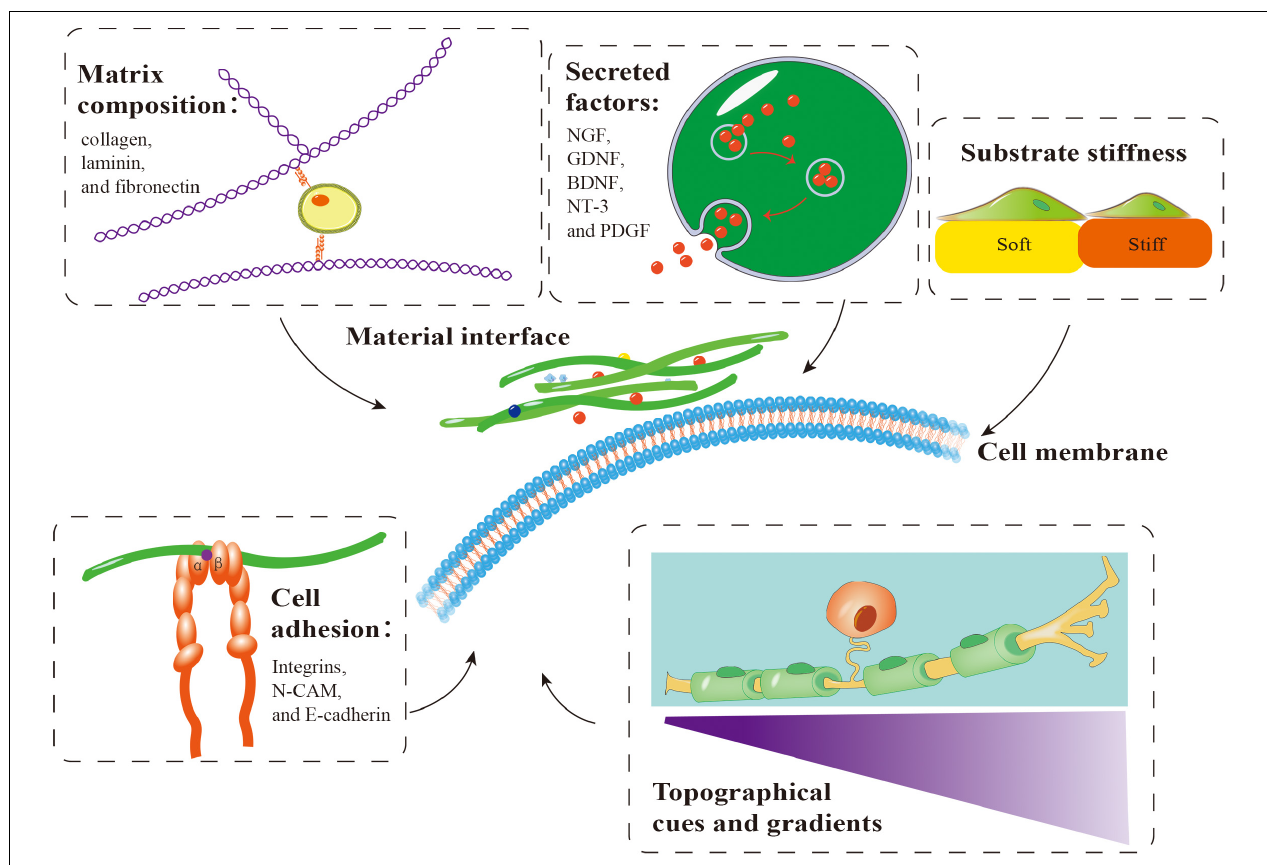
FIGURE 4 | Important factors involved in the application of biomaterials in combination with Schwann cells (SCs) in peripheral nerve regeneration. Matrix components, secreted factors, cell adhesion, substrate stiffness and topographical cues and gradients influence the behavior of SCs on biomaterials, which is crucial for peripheral nerve regeneration. NGF, nerve growth factor; GDNF, glial-derived neurotrophic factor; BDNF, brain-derived neurotrophic factor; NT-3, neurotrophin-3; PDGF, platelet-derived growth